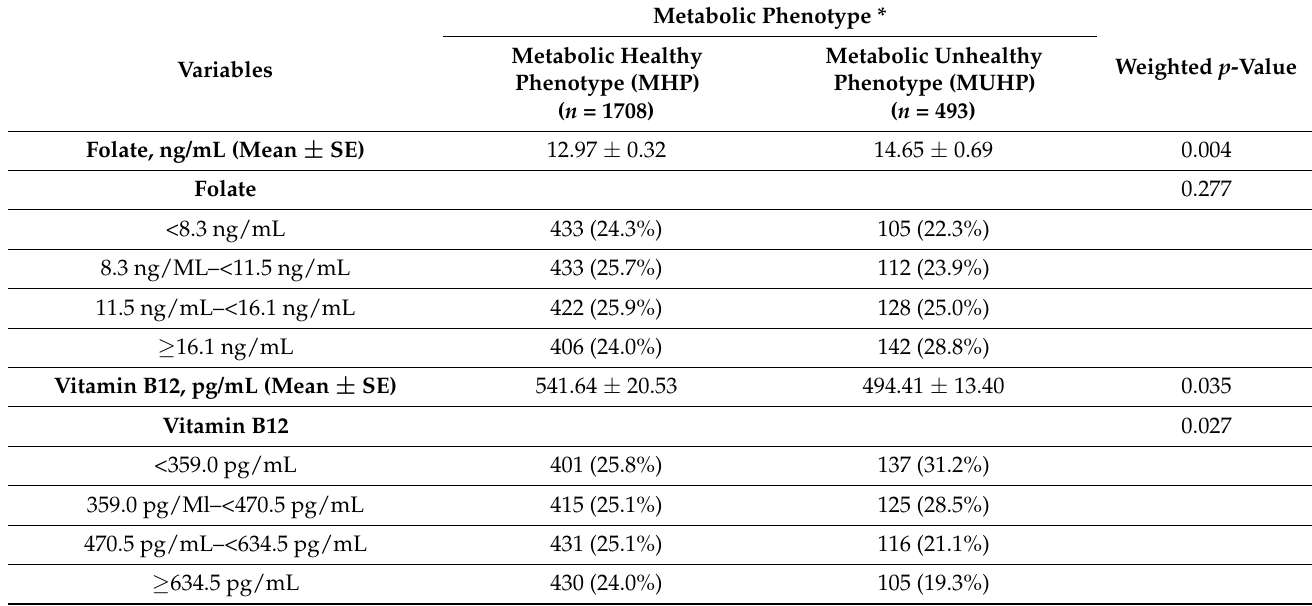
Table 5. Correlations between plasma folate and vitamin B12 levels with metabolic phenotypes.